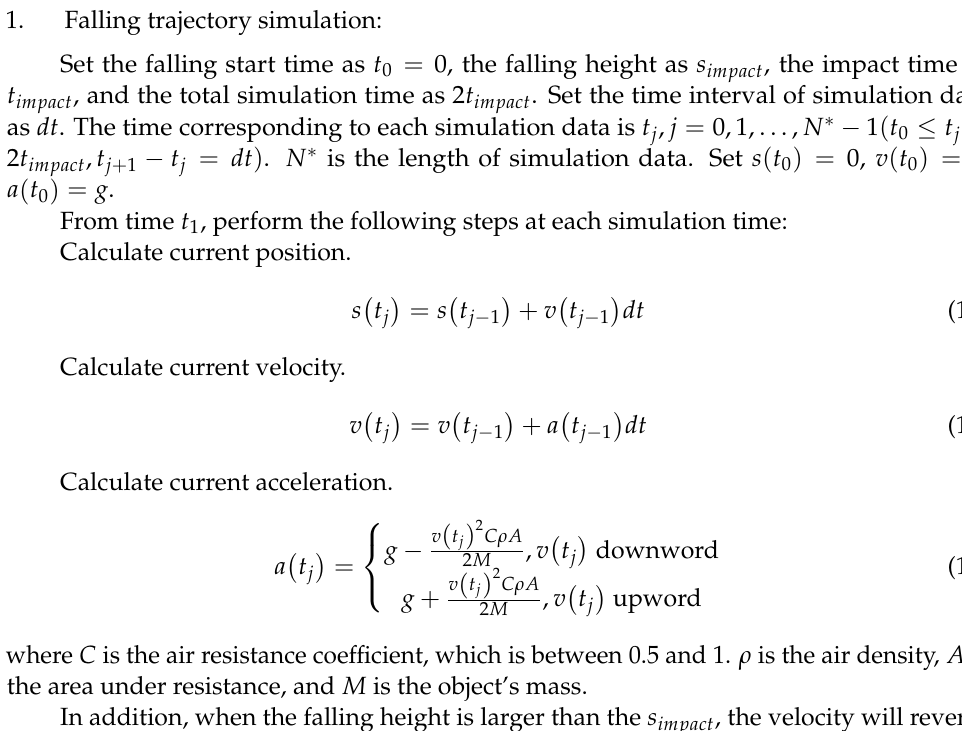
Figure 4. Specific steps of simulation experiment.